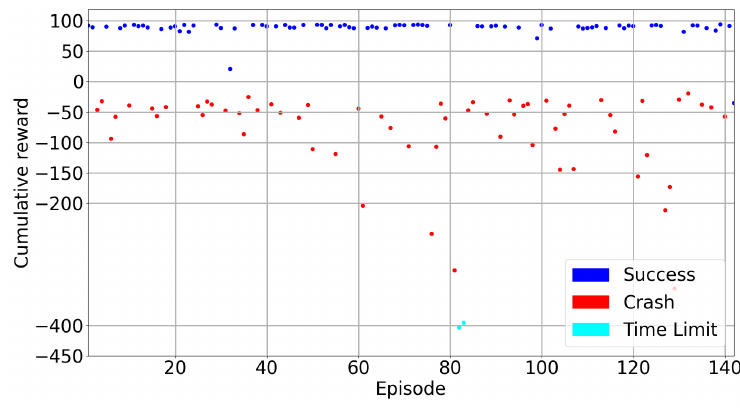
Figure 17. DQfD Train Results.